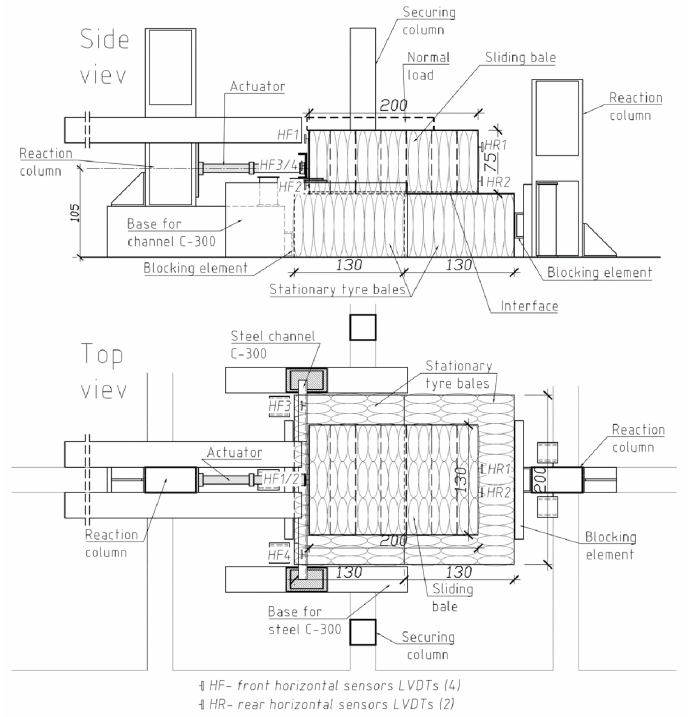
Figure 7. Scheme of tyre–tyre interface test (without additional normal